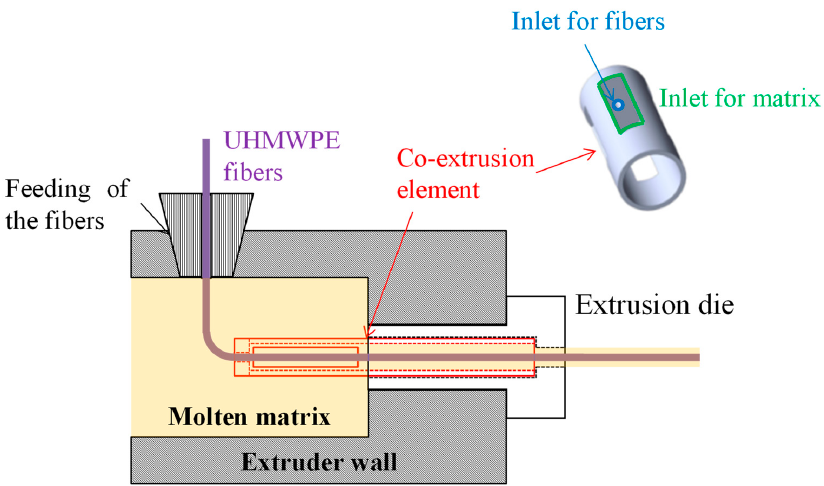
Figure 1. Scheme of co-extrusion.